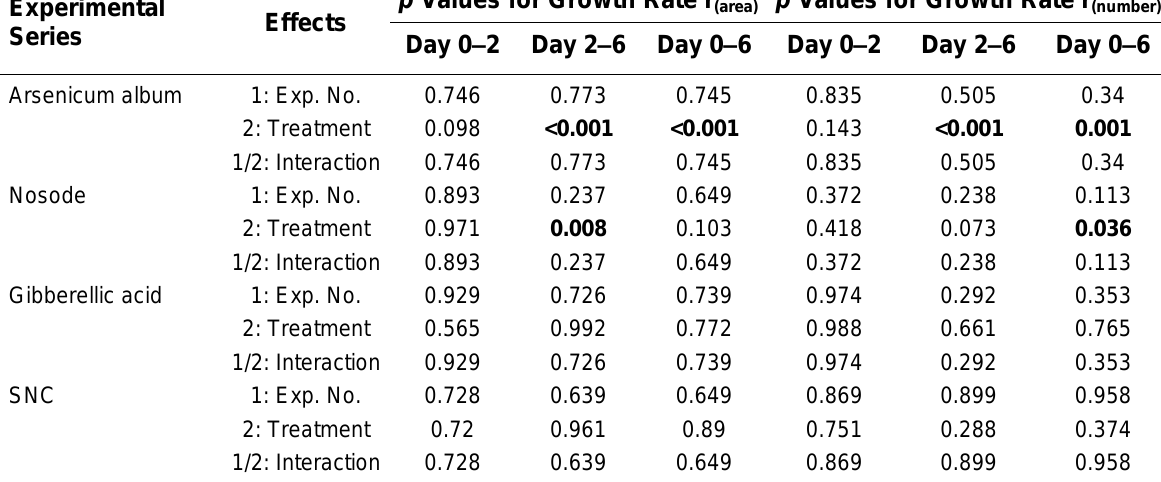
ANOVA Analysis of the Four Main Experimental